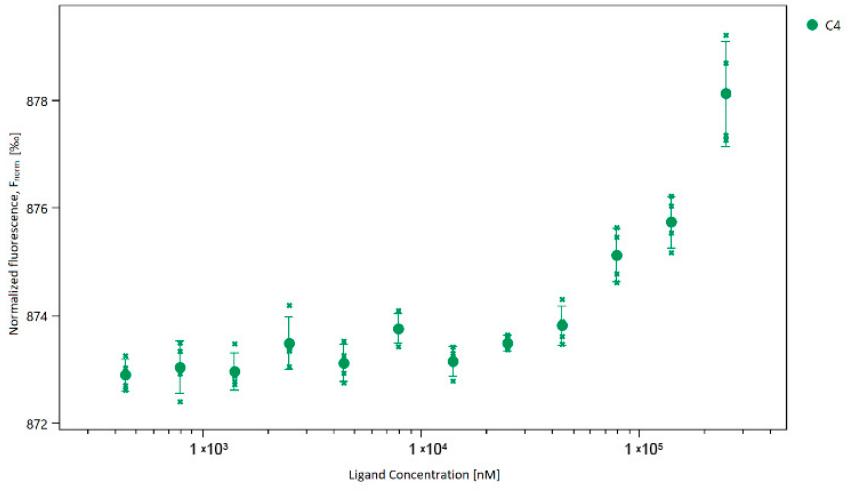
Figure 4. The binding curve of the compound C4 to the SARS-CoV-2 M pro